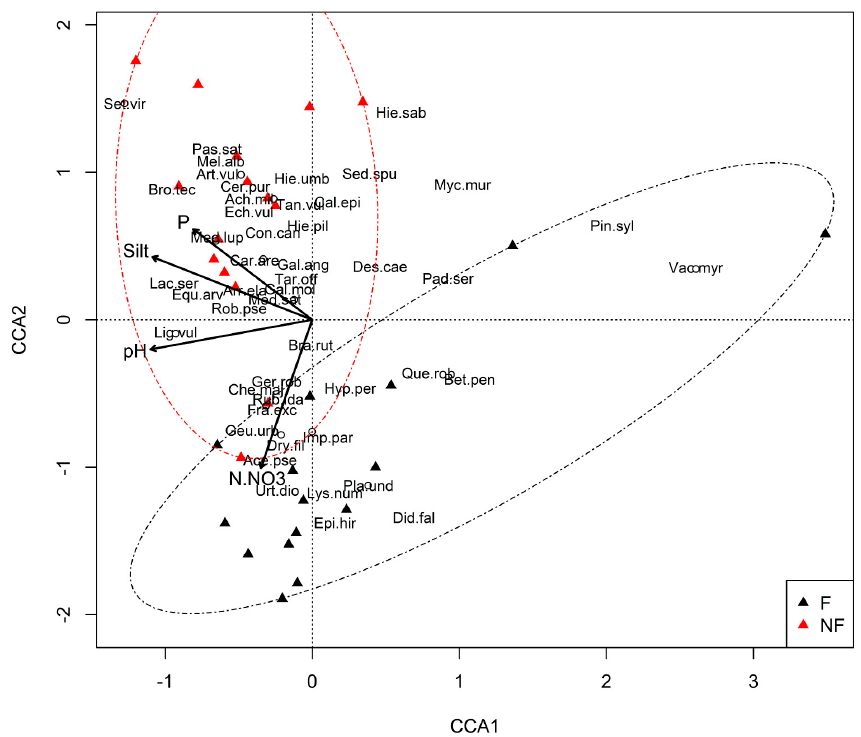
Figure 4. The species correlation with the environmental variables on the examined plots presented by CCA analysis. The eigenvalues of the CCA axes were: 0.631 (1 axis) and 0.512 (2 axis). Explanations: see section Materials and Methods (subsection: Abbreviations).